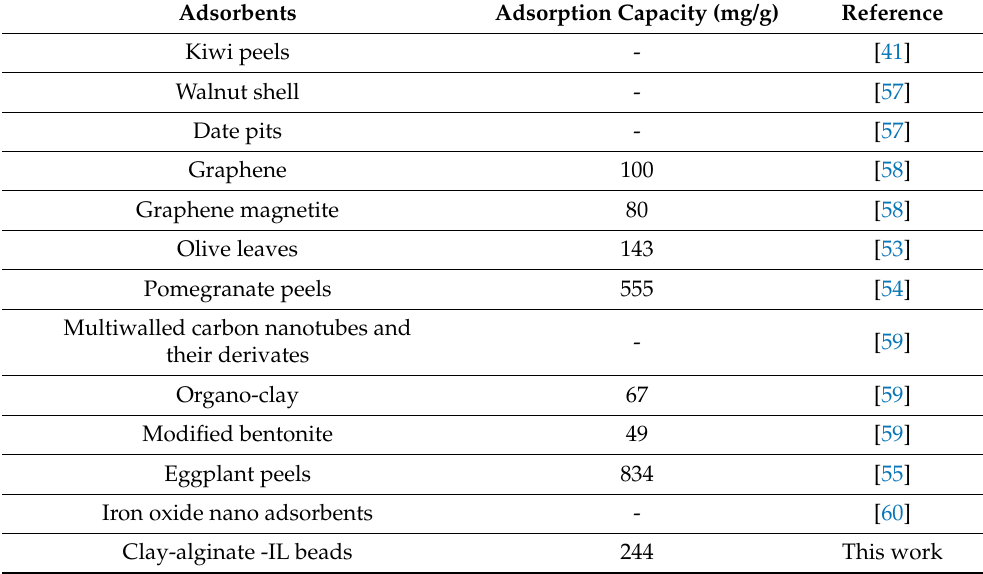
Table 3. Comparison of the different adsorbents used for the removal of oil from the